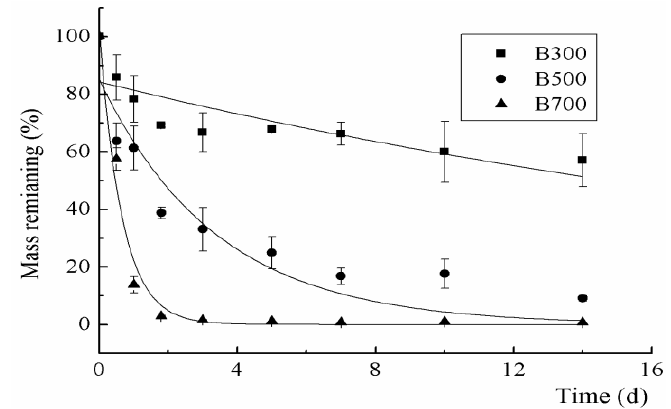
Figure 6. Fitting curves of the CP degradation in biochar produced under different temperatures. The first-order kinetics model was used to fit degradation data.